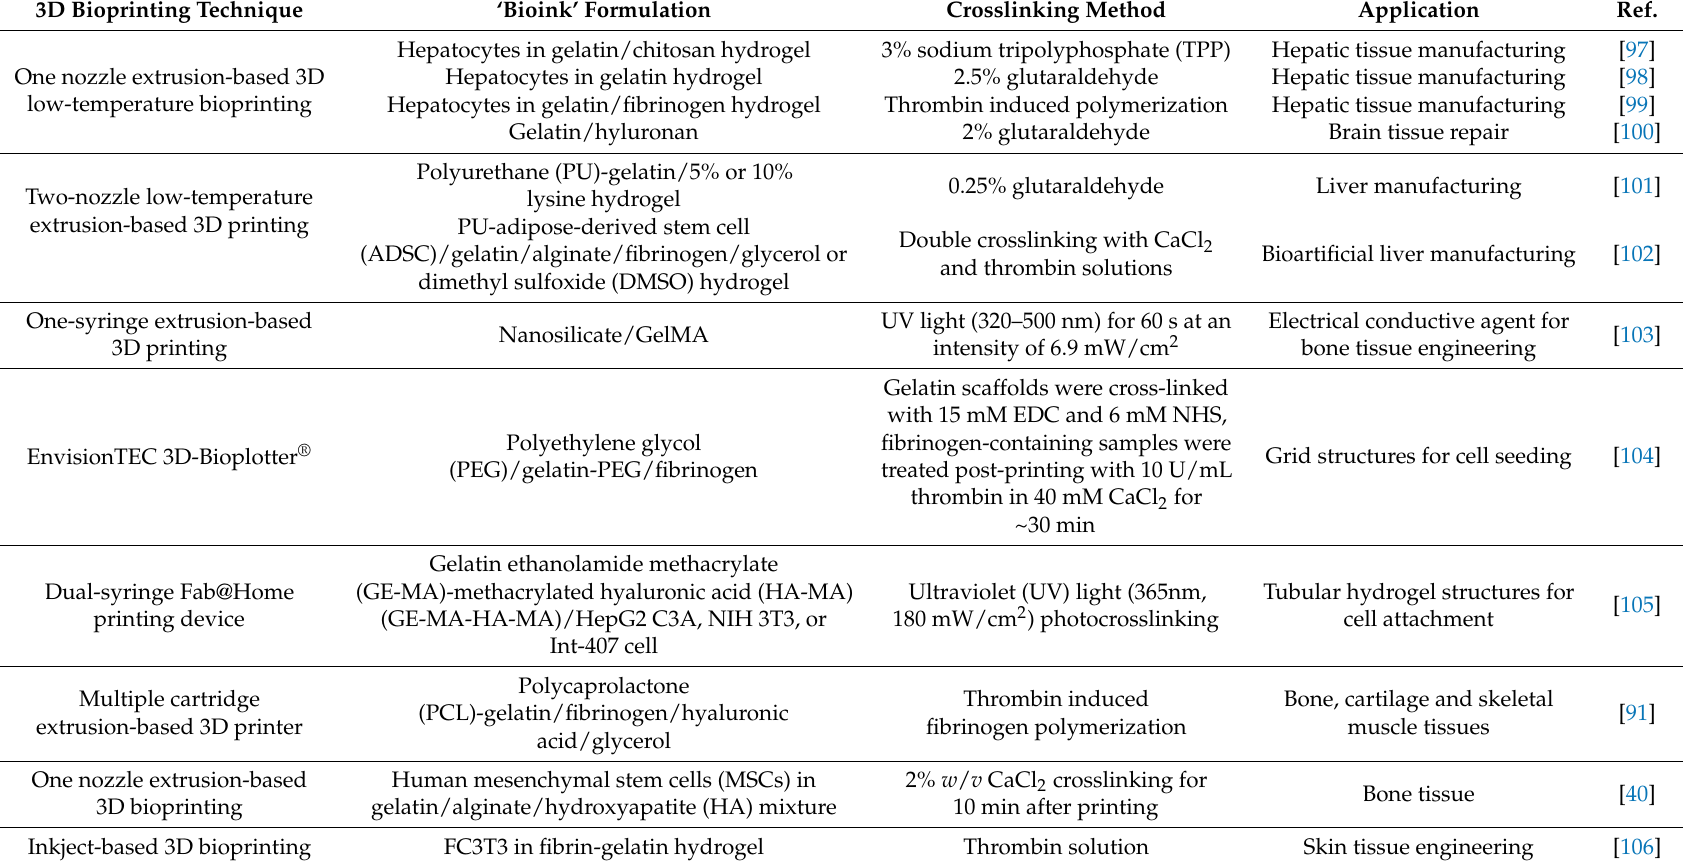
Table 3. Gelatin containing ‘bioinks’ for different 3D bioprinting